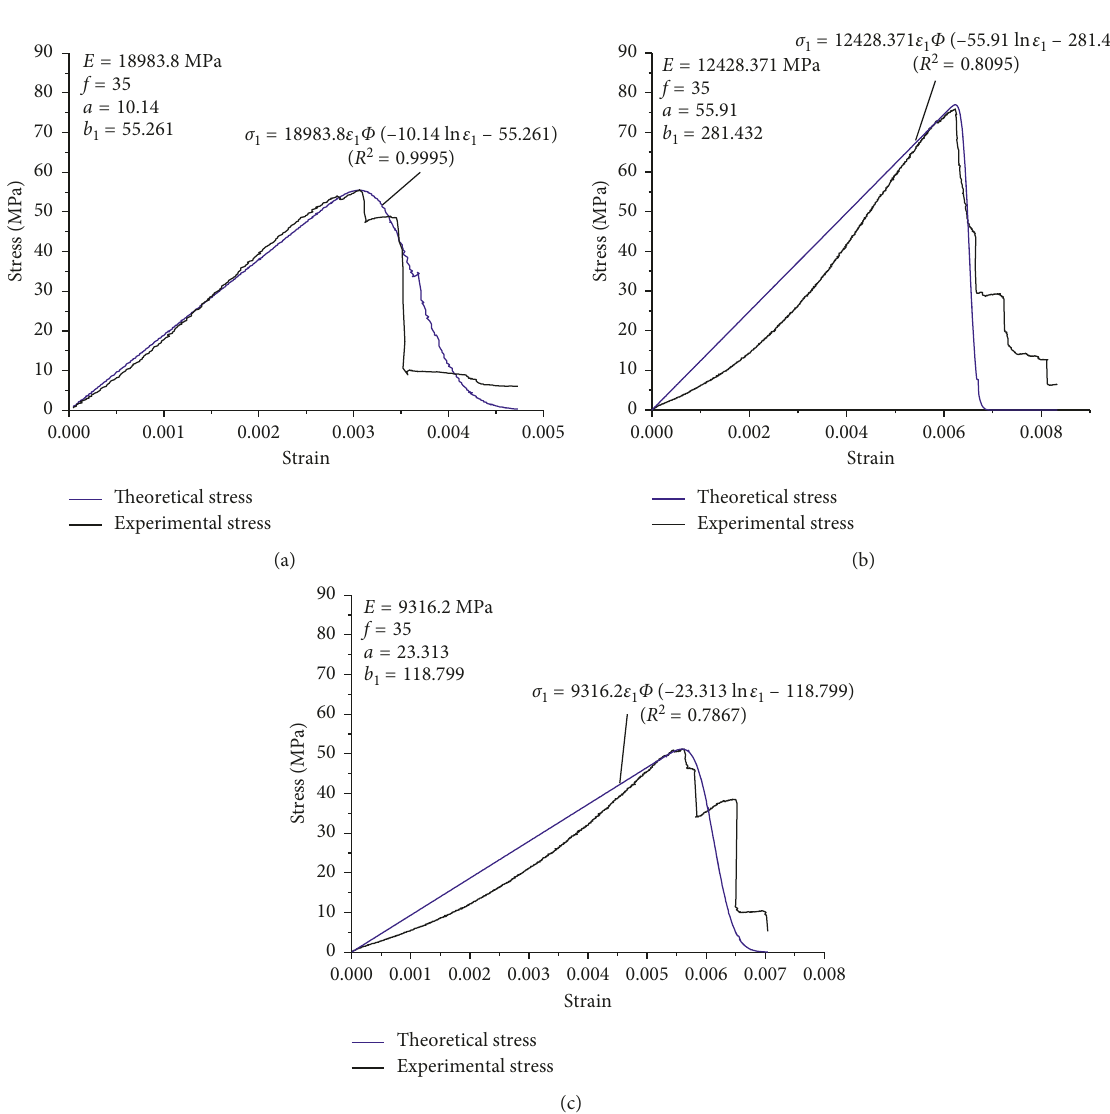
Figure 3: Comparison of theoretical results and experimental data. (a) Sample no. 1. (b) Sample no. 2. (c) Sample no.